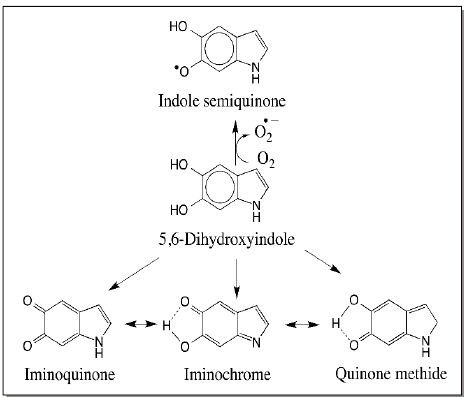
Figure 21. Possible reactive intermediates generated from DHI. DHI can undergo easily oxidation with molecular oxygen producing reactive semiquinones. In addition it is also susceptible to two-electron oxidation generating quinone, quinone methide and